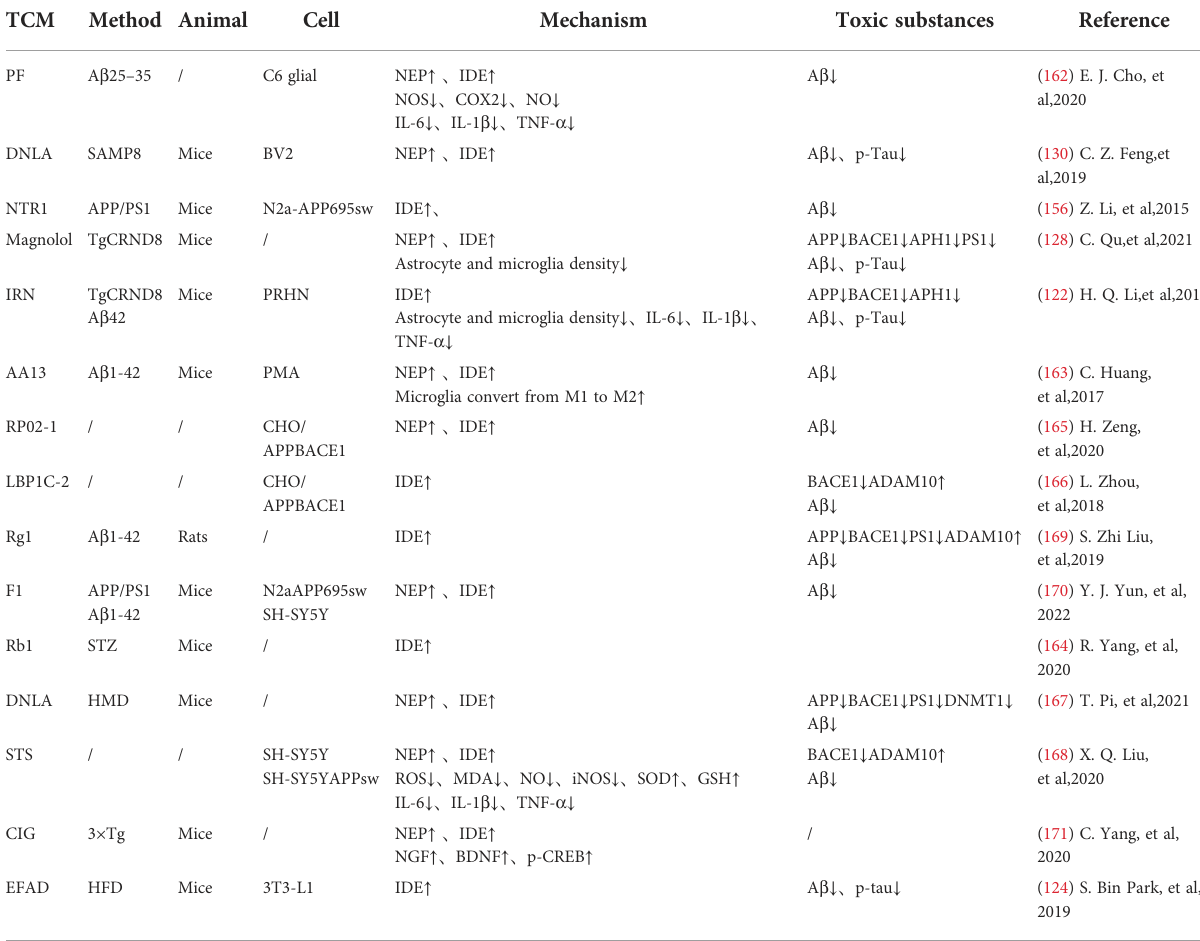
TABLE 4 TCM increase insulin signaling pathway related toxic degradation